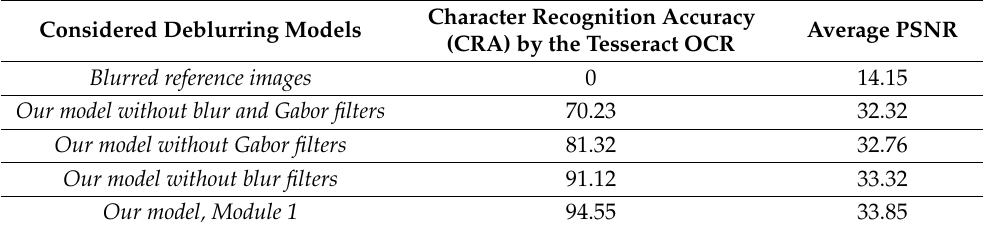
Table 2. Showing the result of ablation study for the blur enhancement.